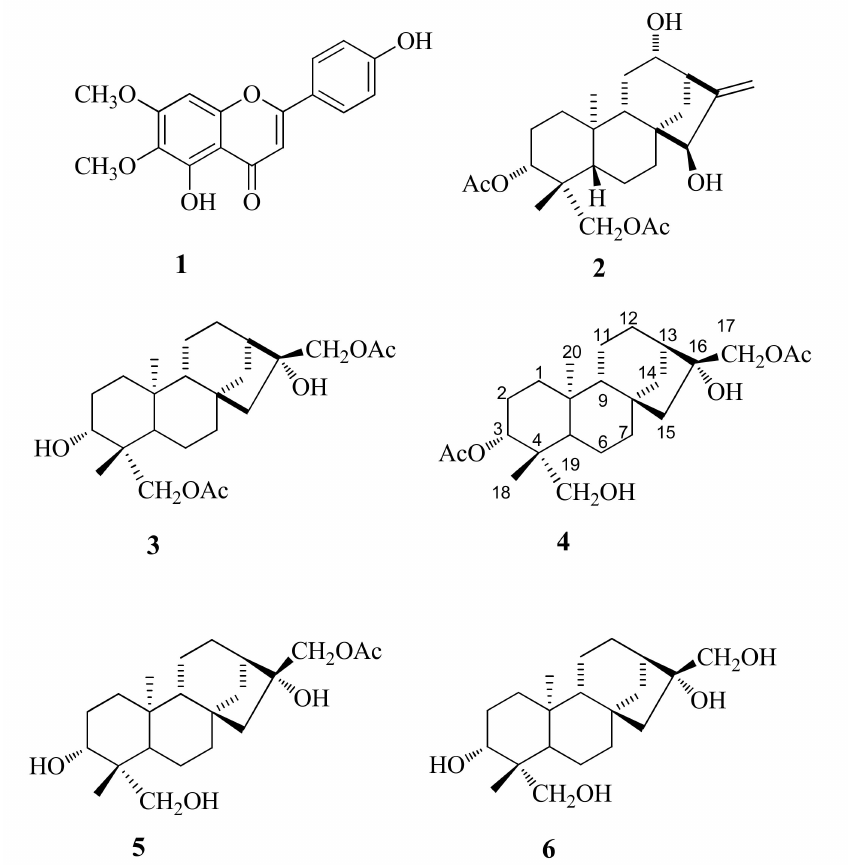
Figure 4. Structures of flavonoid ( 1 ) and diterpenes ( 2 – 6 ) isolated from fraction D of M. pul- chrum